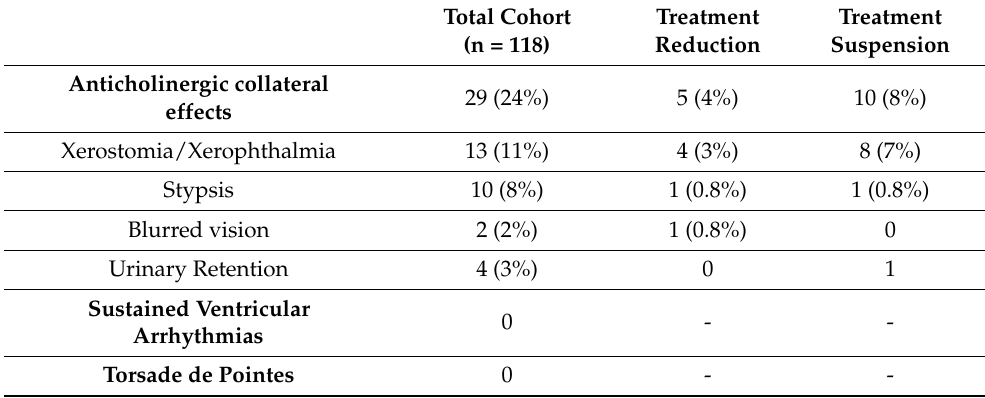
Table 4. Collateral effects of patients undergoing disopyramide treatment.